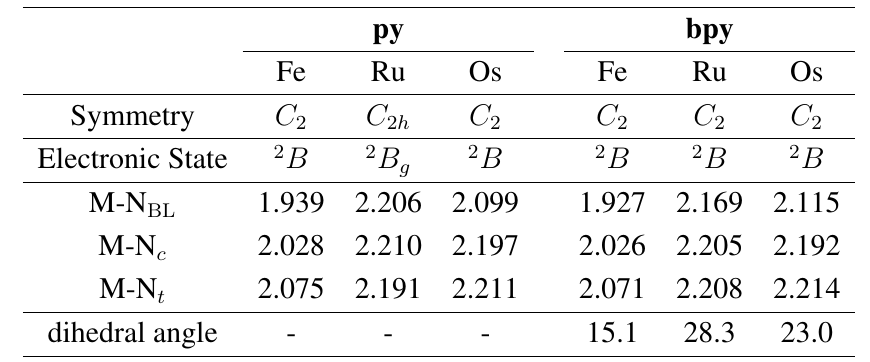
Summary of symmetries, irreducible representations of electronic state, and computed M-N bond lengths ( ˚A) of py and bpy complexes. M-N over all M-N c